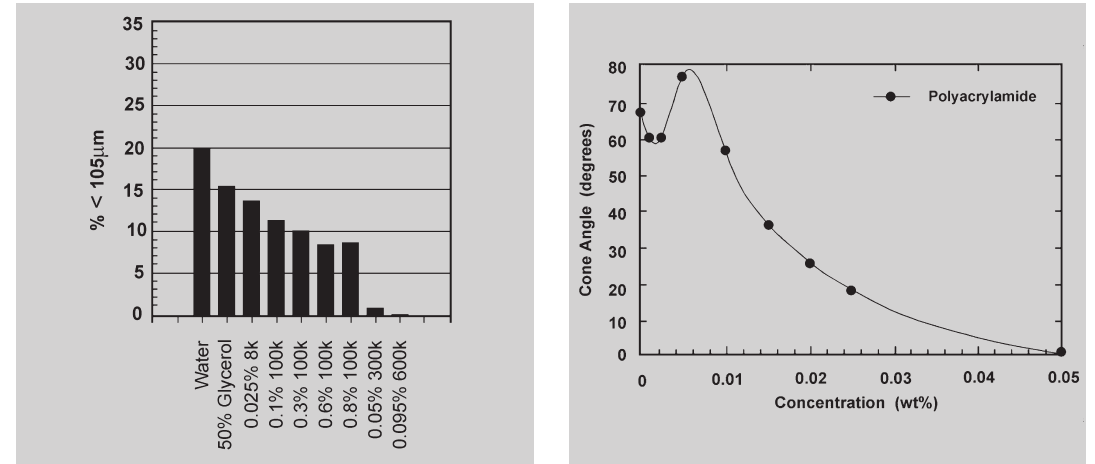
Figure 8 (left): Percentage of droplets formed (<100 mm diameter) for the test solutions atom- ised in a TG-SS Full Jet. Figure 9: Cone angle versus concen- tration in weight percent for an atomised polyacrylamide